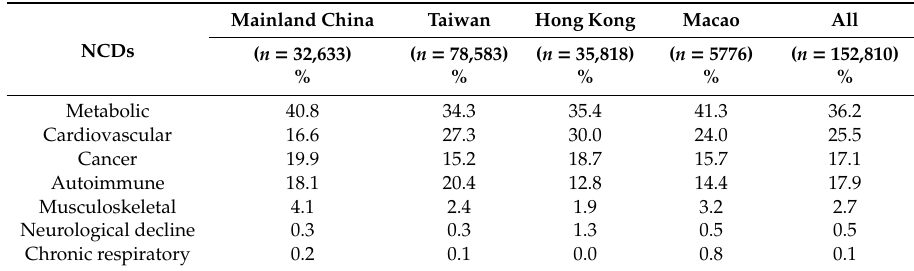
Table 1. A comparison of NCDs coverage on seven diseases categories in mainland China, Taiwan, Hong Kong, and Macao between 2010–2019.